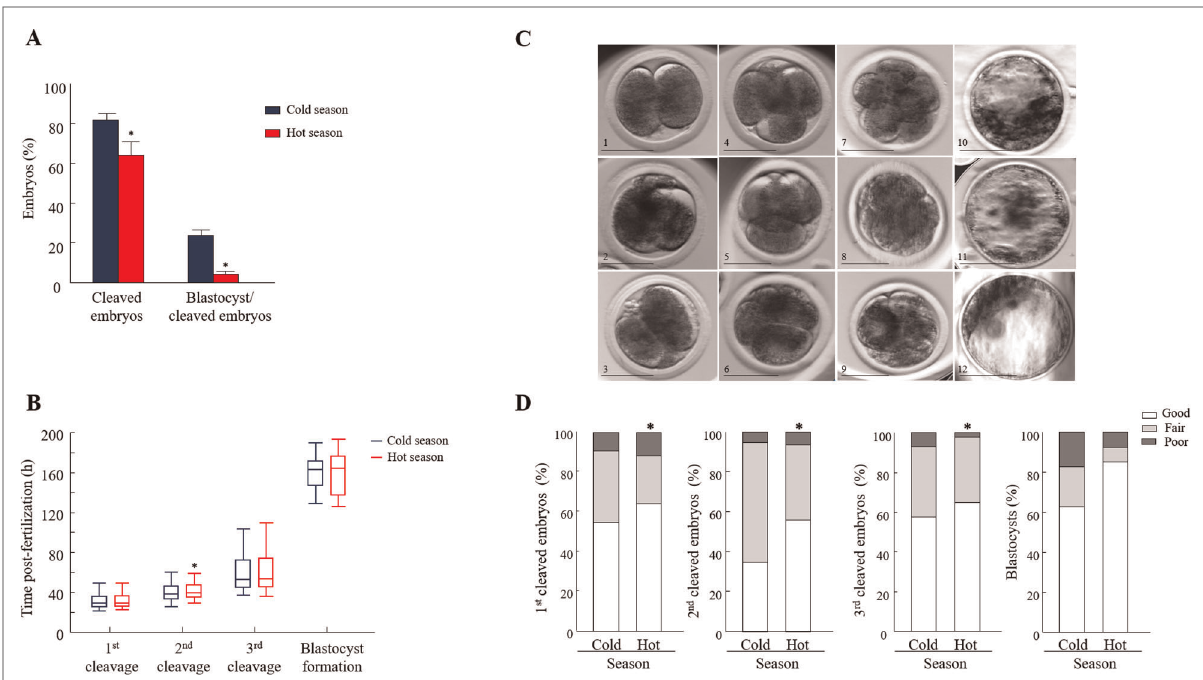
FIGURE 2 Seasonal effect on oocyte developmental competence and morphokinetics . ( A ) Cleavage and blastocyst formation rates calculated from the cleaved embryos ( n =1676, 677 COCs were collected in the cold season and 999 COCs were collected in the hot season). Data are presented as the means±SEM. ( B ) Embryo kinetics was based on the timing post-fertilization of the fi rst, second, and the third divisions and the time of blastocyst formation ( n =559 synchronously cleaved embryos). Data are presented in whisker plots and indicate the maximum and minimum values within the acceptable range de fi ned by the two quartiles. Boxes indicate the 25th and 75th percentiles, and the middle-horizontal line indicates the median. The line inside the box is the median; the upper whisker is the 95th percentile values and the lower whisker is the 10th percentile. ( C ) Representative morphology images of (1) a 2-cell-stage embryo with equally sized blastomeres (good); (2) a 2-cell-stage embryo with equally sized blastomeres and up to 20% fragmentation or more (fair); (3) a 2-cell-stage embryo with unequally sized blastomeres and >50% fragmentation (poor); (4) a 4-cell-stage embryo with four equally sized blastomeres (good); (5) a 4-cell-stage embryo with equally sized blastomeres and up to 20% fragmentation or more (fair); (6) a 4-cell-stage embryo with unequally sized blastomeres and >50% fragmentation (poor); (7) a 8-cell-stage embryo with equally sized blastomeres (good); (8) a 8-cell-stage embryo with unequally sized blastomeres and minor (<20%) fragmentation (fair); (9) a 8-cell-stage embryo with unequally sized blastomeres and >50% fragmentation (poor); (10) blastocysts with evident inner cell mass (ICM), with many tightly packed cells and many trophoblast (TE) cells that form a cohesive epithelium (good); (11) blastocysts with a few TE cells that form a loose epithelium (fair); (12) blastocysts with ICM presenting loosely grouped cells and TE composed of a few large cells (poor). bar=50 μ m. ( D ): Distribution of 2-, 4-, and 8-cell-stage embryos and blastocysts into the different morphological categories (good, fair, and poor). A Chi-square test, followed by Fisher ’ s exact test, was used for pair comparison within each cleavage between seasons. n =559 synchronously cleaved embryos; 101 synchronously blastocysts. * p